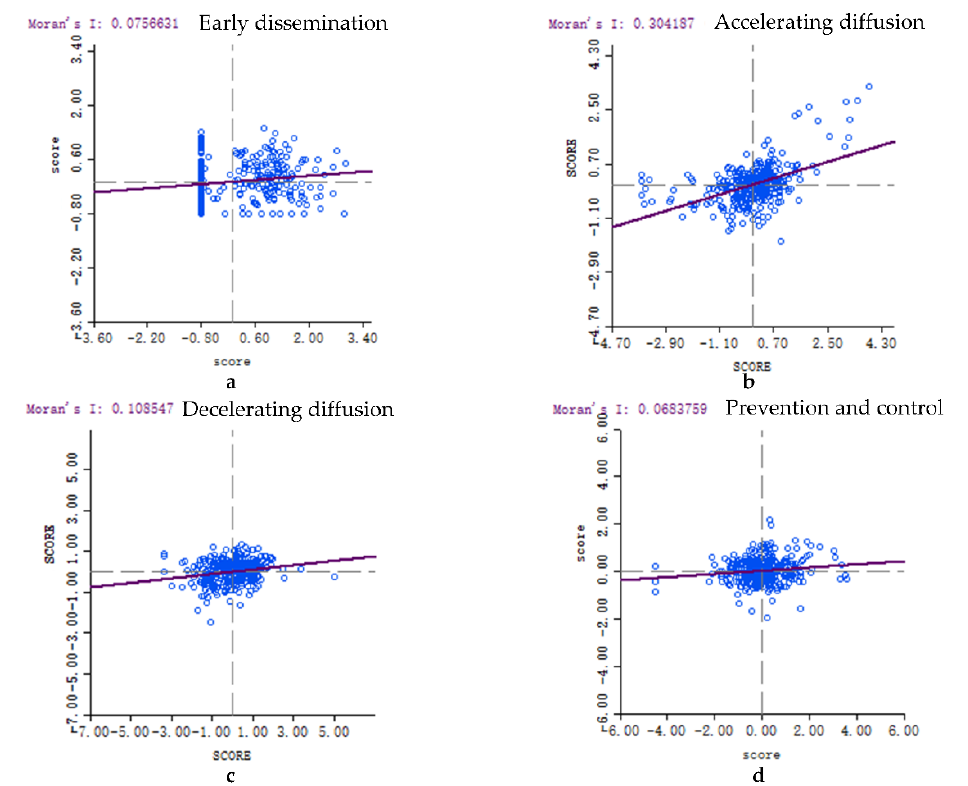
Figure 5. Moran scatter plot of environmental risk perception during COVID-19.